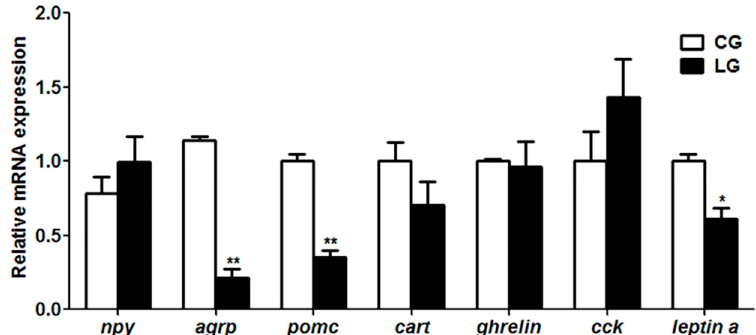
Figure 3. Appetite control genes expression in mandarin fish (CG) with the negative demonstration fish (wild mandarin fish without training) and fish (LG) with the positive demonstration fish (pre-trained mandarin fish which could accept dead prey fish). Data are represented as mean ± S.E.M. ( n = 6). A value followed by * di ff ers significantly from all other values not followed by the same superscript at the same time point based on a one-way analysis of variance (ANOVA) followed by the post hoc test (* p < 0.05, ** p < 0.01).